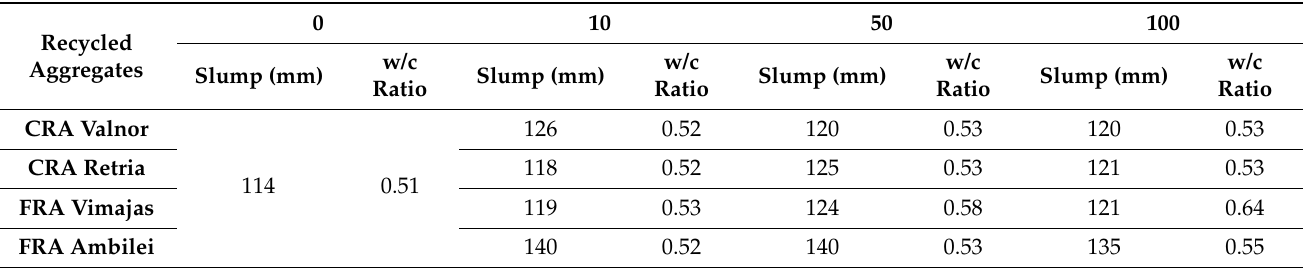
Table 6. Slump and effective w/c ratio of the concrete